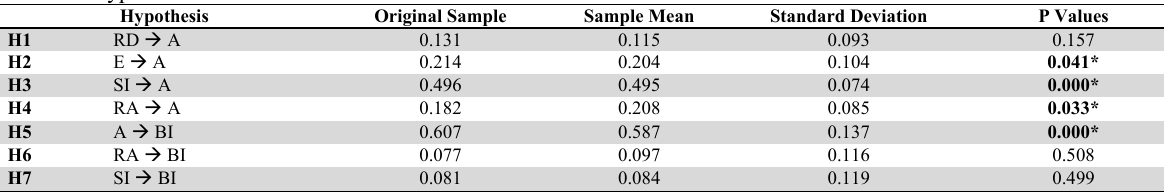
Results of hypotheses